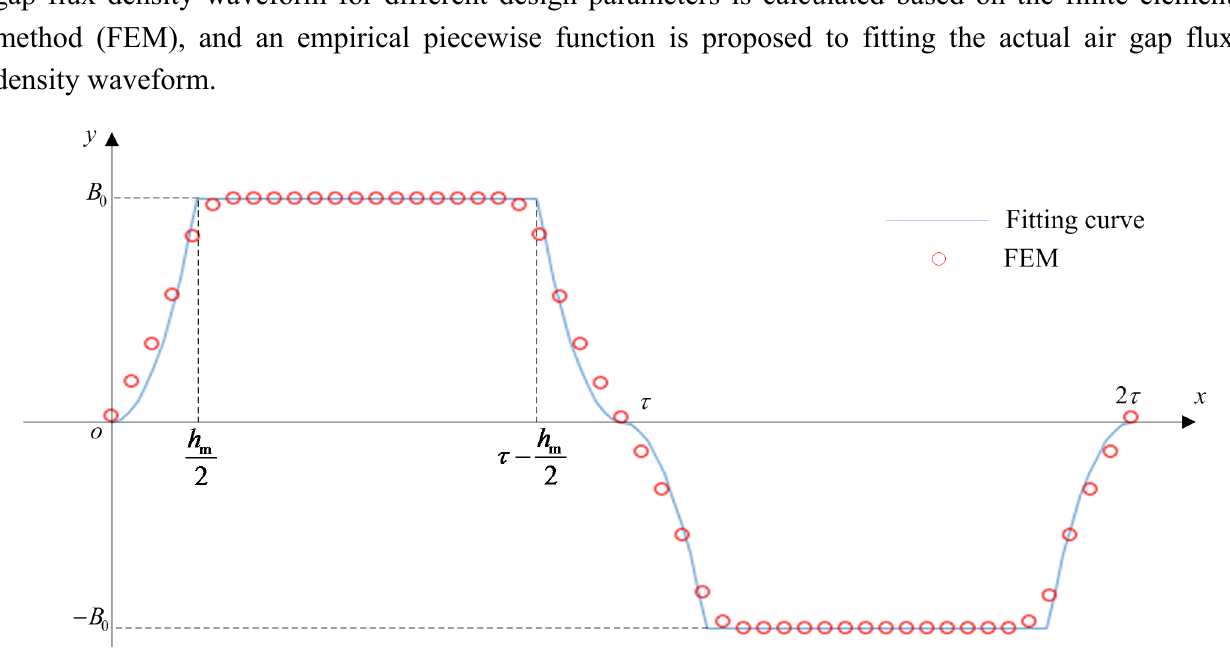
Figure 4. Waveform of the air gap flux density at the speed of 0